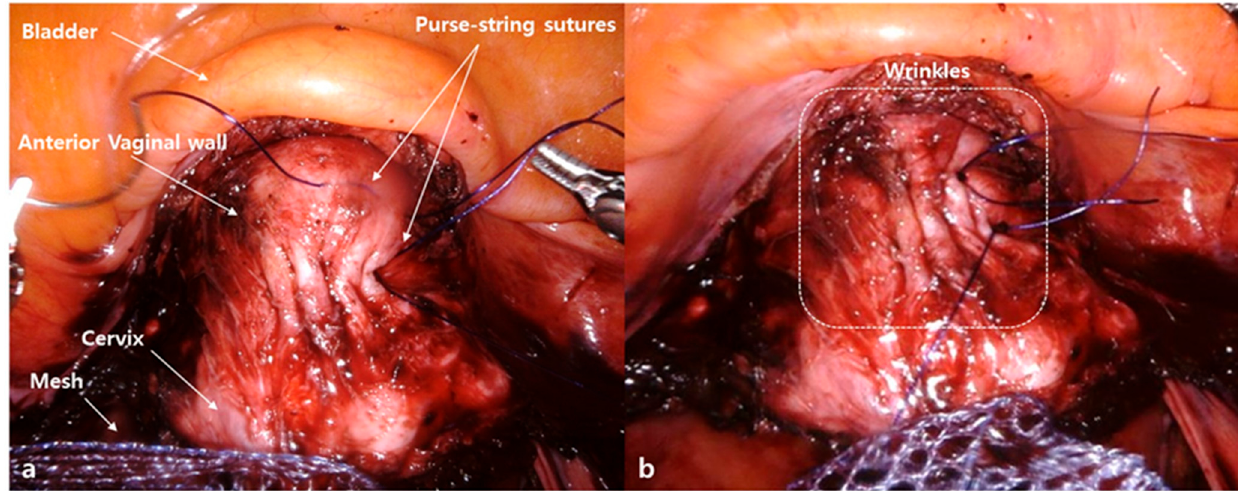
Figure 1. The wrinkle method. ( a ) Creation of two or three rows of purse-string sutures with delayed absorbable monofilament suture material (2-0 PDS; Ethicon, Johnson & Johnson, New Brunswick, NJ, USA) on the anterior vaginal wall. ( b ) Creation of wrinkles on the anterior vaginal wall and anchoring of the mesh on the wrinkle.